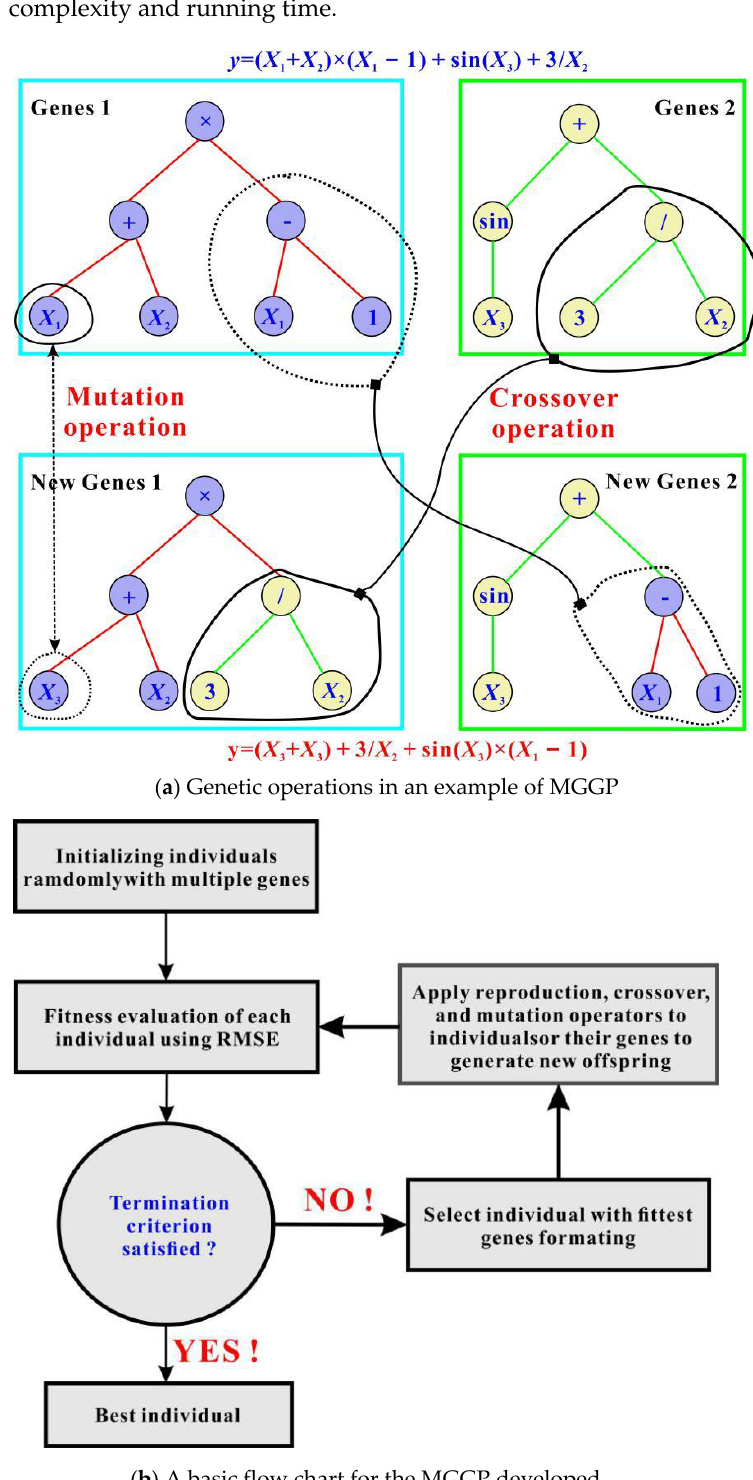
Figure 5. Illustration and flow chart of MGGP [31].